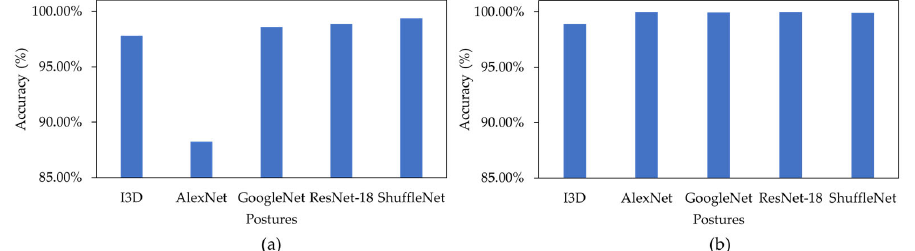
Figure 7. ( a ) A comparison between all weighted LOSO models, and ( b ) a comparison between all weighted 5 ‐ fold